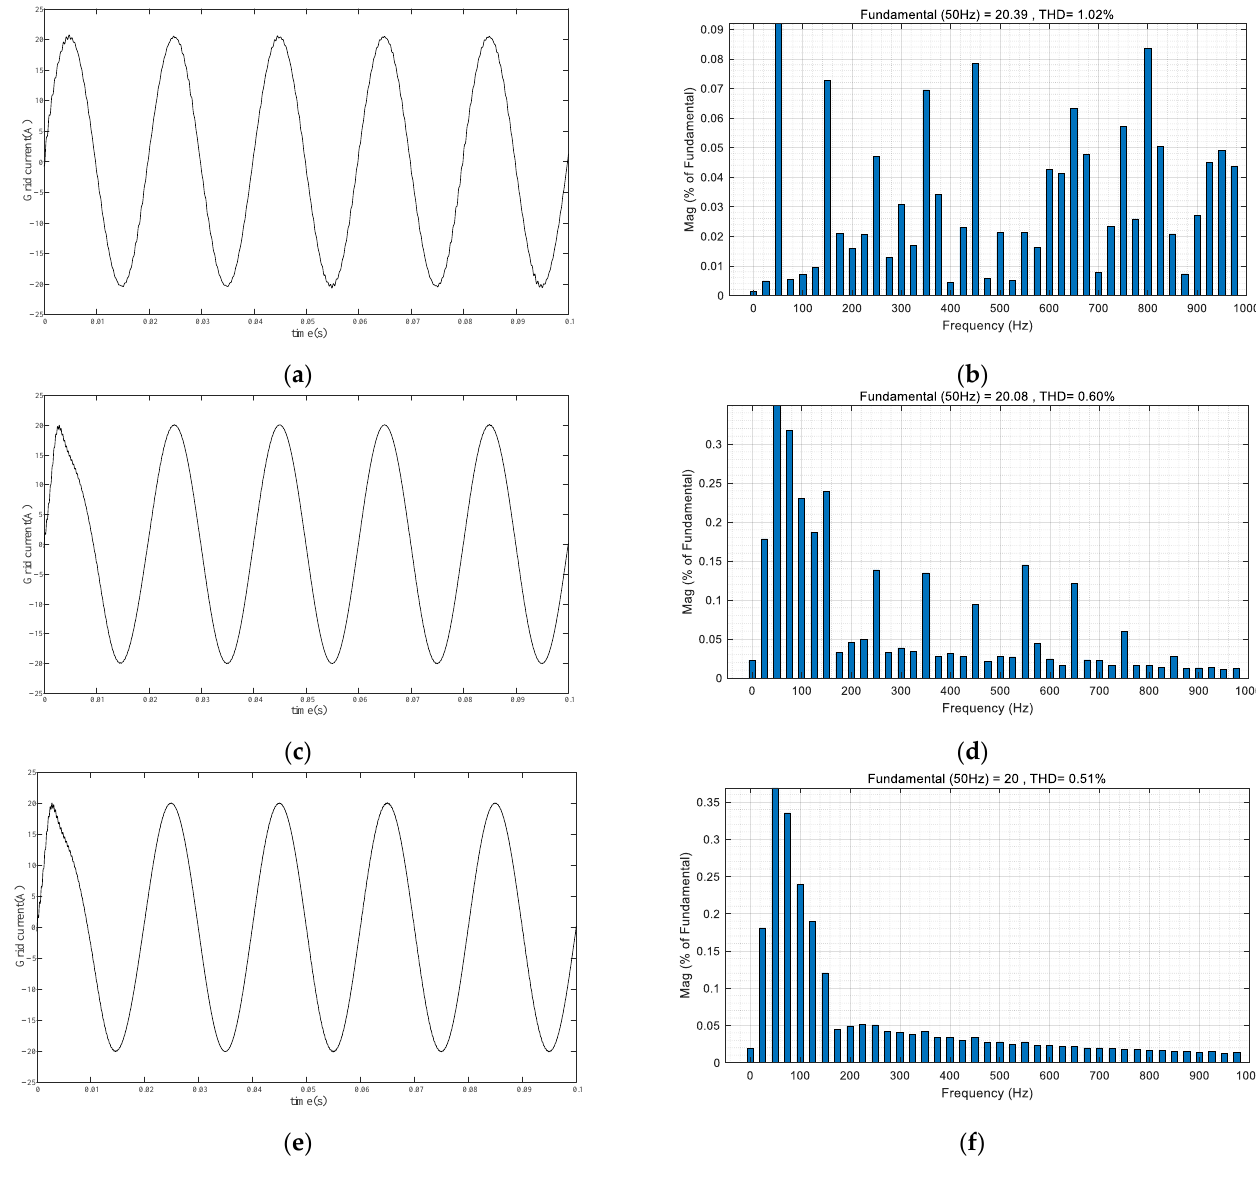
Figure 9. Simulation results under strong grid conditions. ( a ) Grid current under conventional control; ( b ) THD analysis of grid current under conventional control; ( c ) Grid current under ADRC + PBC; ( d ) THD analysis of grid current under ADRC + PBC; ( e ) Grid current under FUZZY - ADRC + PBC; ( f ) THD analysis of grid current under FUZZY - ADRC + PBC. Table 3. THD analysis of grid - connected current under strong grid conditions.